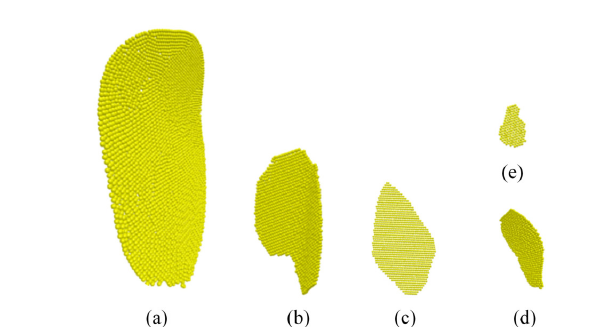
Figure 2. Five types of tobacco strips models: ( a ) Large tobacco strips; ( b ) Medium tobacco strips I; ( c ) Medium tobacco strips II; ( d ) Medium tobacco strips III; ( e ) Small tobacco